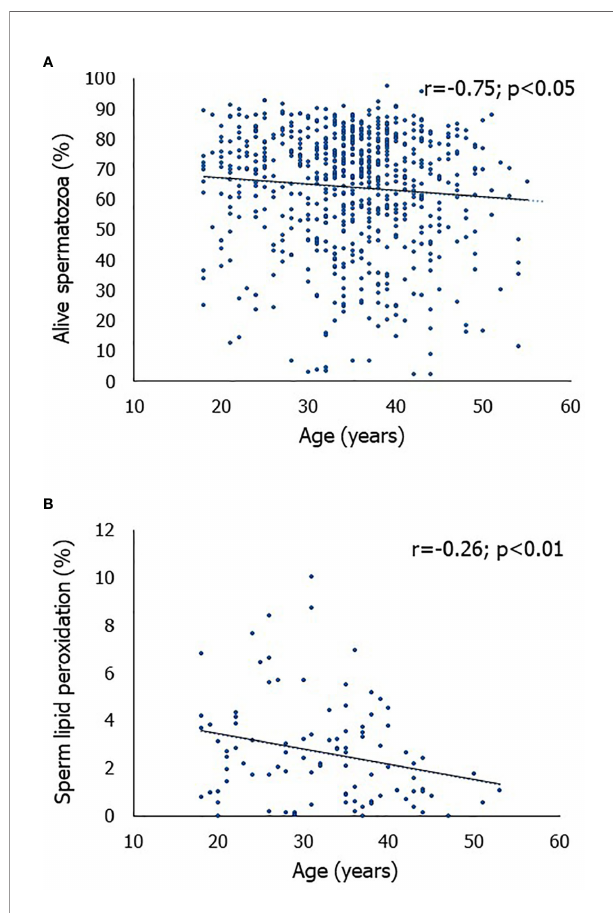
FIGURE 1 | Scatterplot of the correlations between age of the men enrolled in this study and the percentage of alive spermatozoa (A) and between age and the percentage of spermatozoa with lipid peroxidation (B) .